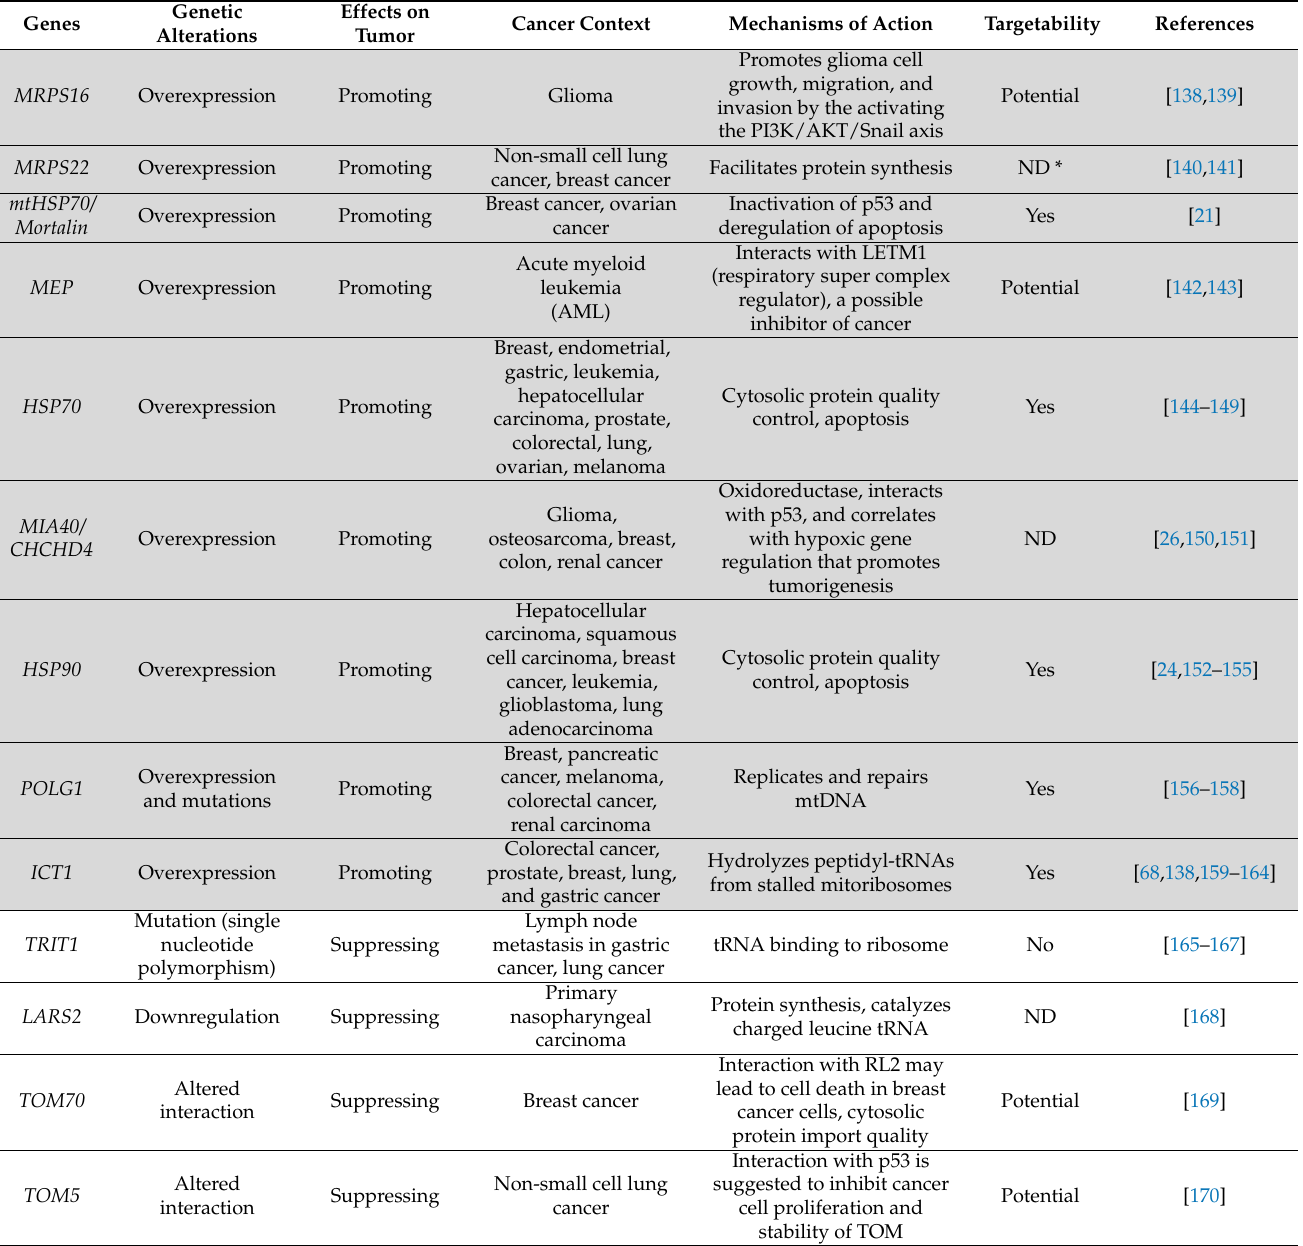
Table 1. MPQC players involved in